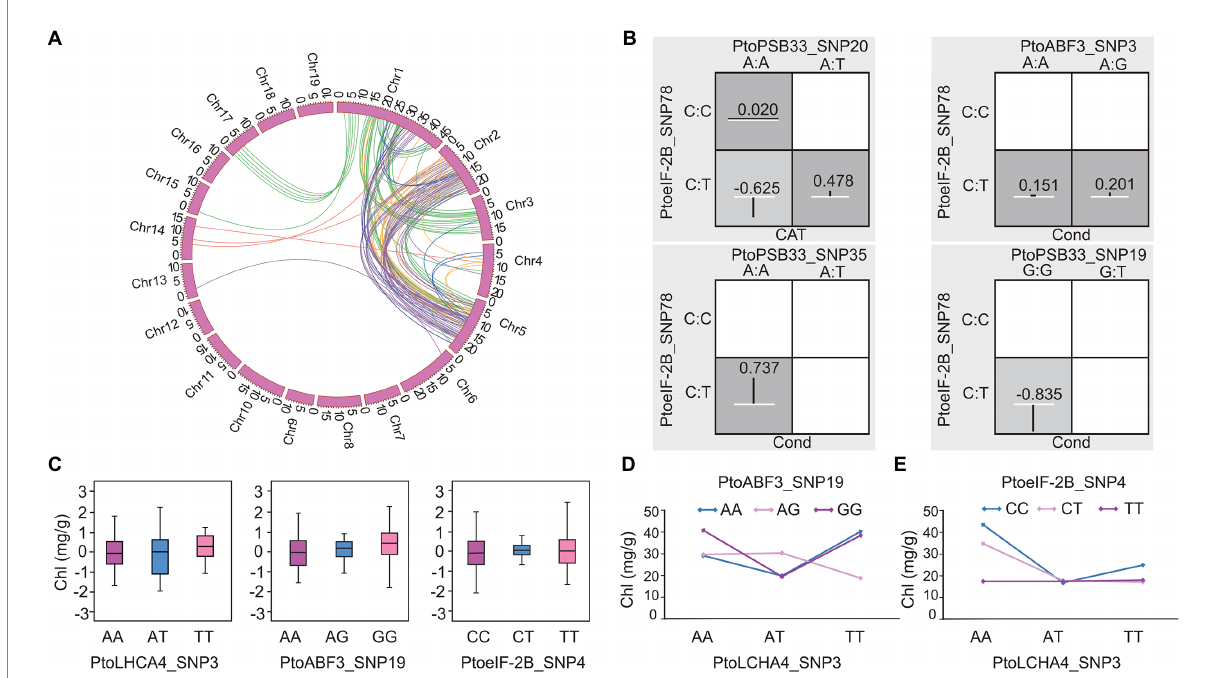
FIGURE 3 Allelic interactions between significant pairwise SNPs in candidate genes related to the co-expression network of drought stress traits. (A) Circos plot showing 104 pairwise interactions for drought stress-related traits ( p < 0.001). The 19 P. tomentosa chromosomes (Chr1-19) are shown in a circle. Interior lines represent the pairwise interactions that underlie six drought stress-related traits; colored lines represent different categories [green, purple, orange, red, dark blue, and light blue indicate relative chlorophyll content (Chl), stomatal conductance (Cond), net photosynthesis (Pn), proline content (PRO), transpiration rate (Trmmol), and catalase activity (CAT), respectively]. (B) Epistatic effects of different genotypic combinations for drought stress-related traits. Dark-shaded cells represent high-risk genotype combinations, while light-shaded cells represent low-risk genotype combinations. Values in boxes are individual information gains and positive values along the line indicate positive interactions. The white line in the middle of each box represents the mean phenotypic value of the population, while the vertical line represents the difference between the mean phenotypic value of each genotype combination and the overall mean. The width of the vertical line in the box indicates the number of individuals in this genotype combination. The negative values can be explained as negative interaction/redundancy (i.e., the amount of information shared by the attributes). (C) Genotypic effects of chlorophyll content (Chl) causal SNPs. (D,E) Epistatic effects for chlorophyll content between PtoLHCA4_SNP3 with PtoABF3_SNP19 and